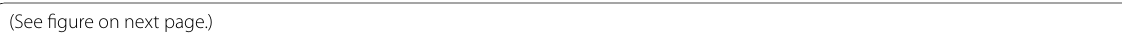
figure on next Fig. 4 Disease-free survival (DFS) for five-year follow-up according to the spatial TILs phenotype and sTILs scores. Disease-free survival (DFS) was calculated as number of months from the date of surgery till the recurrence diagnosis date or last follow-up date up to five years. Kaplan-Meier survival plots for disease-free survival (DFS) are plotted. Each drop shown as a vertical line represents an event i.e., local, or distant recurrence. Survival probability with respect to the spatial TILs phenotype is analyzed using IBM SPSS Statistics v. 21.0.0.0. The number of patients at risk at each time interval of 10 months from 0 to 60 months is shown. The number of events is indicated in brackets at respective time points. A‑D DFS for the four phenotypes of the spatial TILs; Intra-tumoral TILs, Peri-tumoral TILs, Stromal TILs, and Desert TILs for A; the IDC cohort, B; ER subtype and D; TNBC subtype. In the graph, X-axis represents the time scale in months, and Y-axis represents the survival probability. The green line indicates patients with stromal TILs, the blue line indicates patients with peri-tumoral TILs, the purple line indicates patients with intra-tumoral TILs, and the red line indicates patients with desert TILs phenotype. E‑H DFS with respect to binned percent stromal TILs infiltration score. Kaplan-Meier survival plots for disease-free survival (DFS) according to low, moderate & high sTILs score bins for E; the IDC cohort, F; ER subtype and H; TNBC. In the graph, X-axis represents the time scale in months, and Y-axis represents the survival probability. The blue line indicates patients with low sTILs scores, and the red line indicates patients with moderate scores & green indicates high sTILs